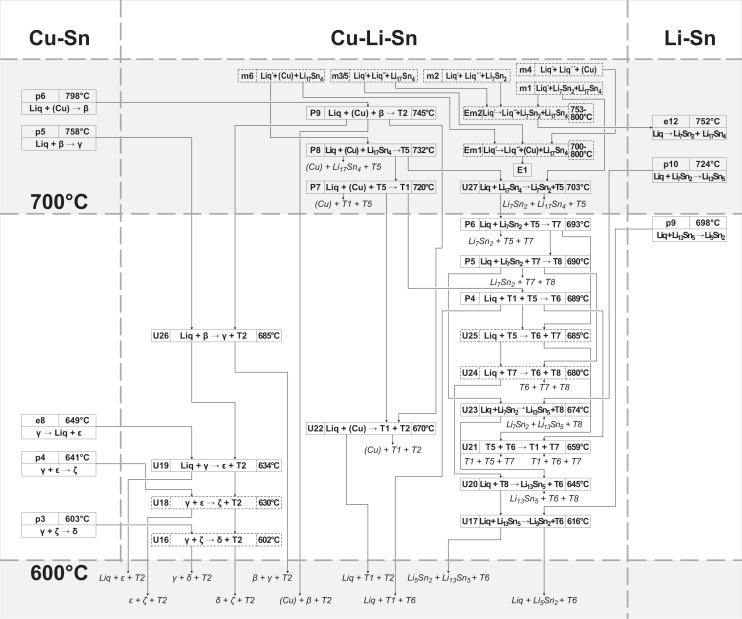
Reaction scheme T > 600°C.